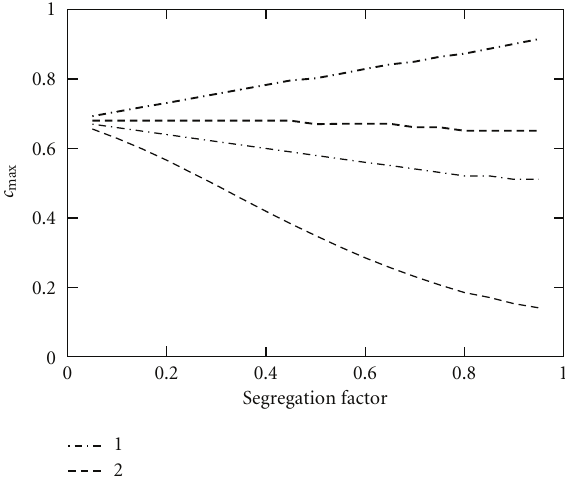
Figure 13: Dependencies of the Reynolds-averaged (curves 1) and Favre-averaged (curves 2) combustion progress variables, associated with the maximum mean heat release rate, on the segregation factor g . F = 1 . 0. Thin and bold curves are associated with P ( c , c , c (cid:3) 2 ) and (cid:2) P ( c , (cid:2) c , ρc (cid:3)(cid:3) 2 /ρ ),